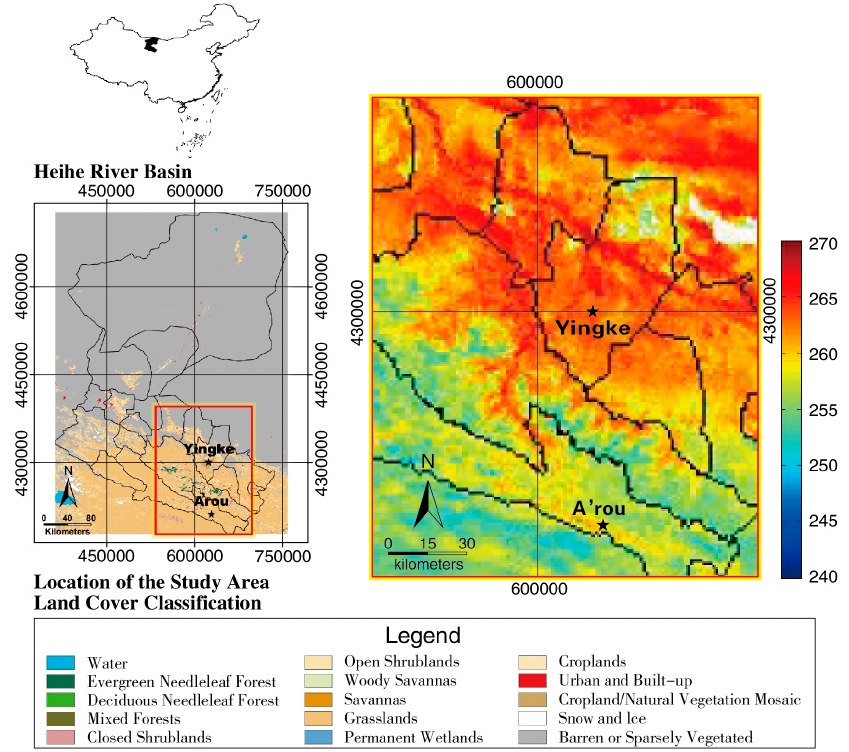
Figure 1. Geographical/Land cover map encompassing the HRB and the two in situ sites position (for details see [27]). The right image is the AATSR LST image on 23 December